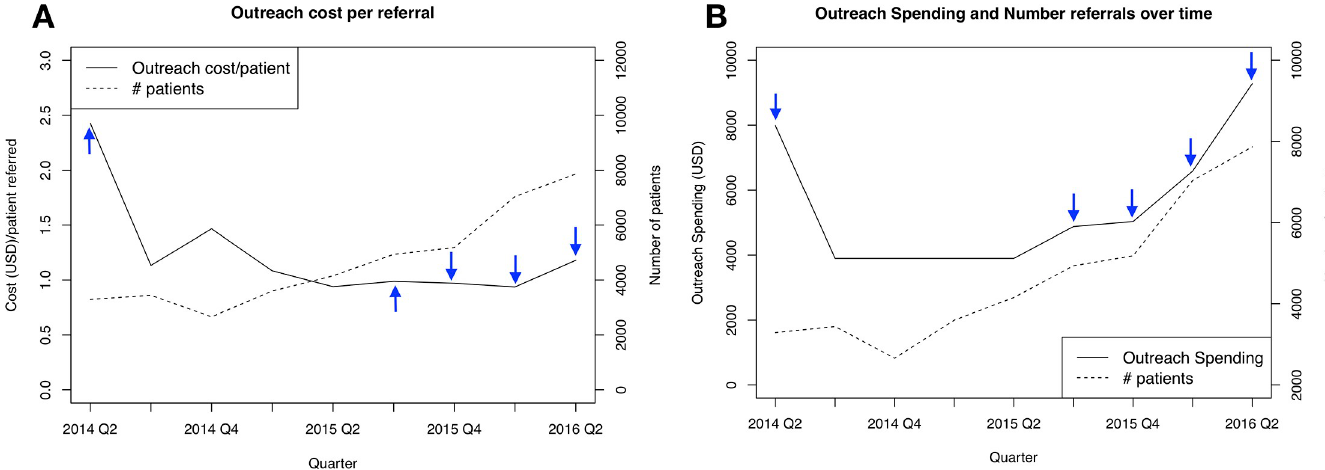
Fig 3. Trends in outreach spending and number of successful patient referral for Xpert testing. Fig 3A represents the trend of outreach spending cost per patient (solid line) referred plotted against the total number of patients referred (dotted line). Fig 3B plots the combined total outreach spending (solid line) against the number of patients referred (dotted line) for each quarter of the study period. Blue arrows indicate quarters where at least one CME was